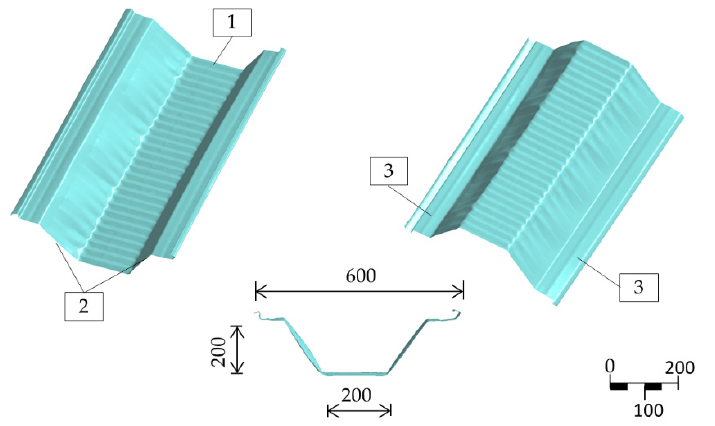
Figure 1. View of an ABM-240 profile fragment after rolling, dimensions in mm. 1—corrugated web, 2—corrugated flange, 3—flat lip.